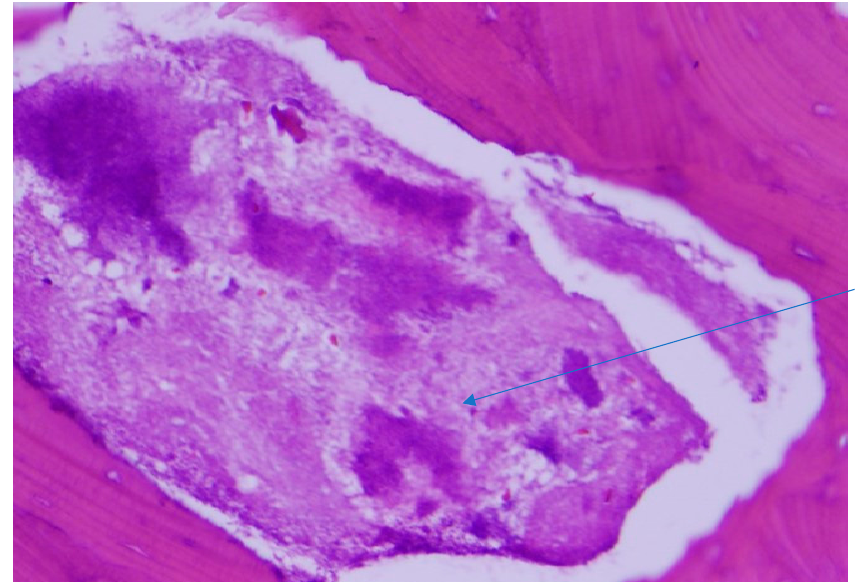
Figure 3. Osteonecrosis of the jaw on hematoxylin and eosin stain. Original magnification ×40.